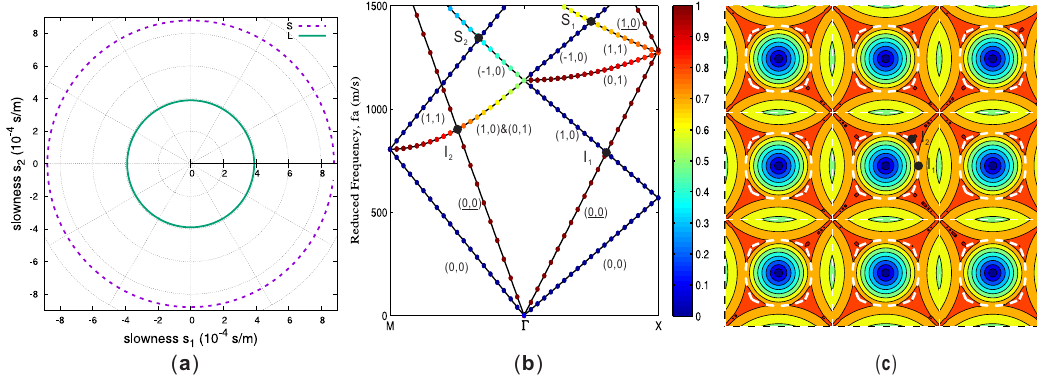
Figure 3. Empty lattice model for in-plane polarized waves in epoxy. ( a ) The slowness curves for pure shear (dashed line) and for pure longitudinal (solid line) waves are both circles. ( b ) The empty-lattice band structure for in-plane polarized waves is shown. Numerical and analytical results are shown with solid circles and lines, respectively. The color scale represents the polarization in the propagation direction, from 0 (shear) to 1 (longitudinal). Each dispersion branch is labeled by an index corresponding to the reciprocal lattice point from which the generating cone originates. Indices for longitudinal branches are underlined for clarity. Points I 1 and I 2 are the first intersections between shear and longitudinal branches. ( c ) Isofrequency curves are plotted for the second band. The thick dashed lines show the first intersection between shear and longitudinal cones, while the thin dashed lines show the first intersection between pure shear